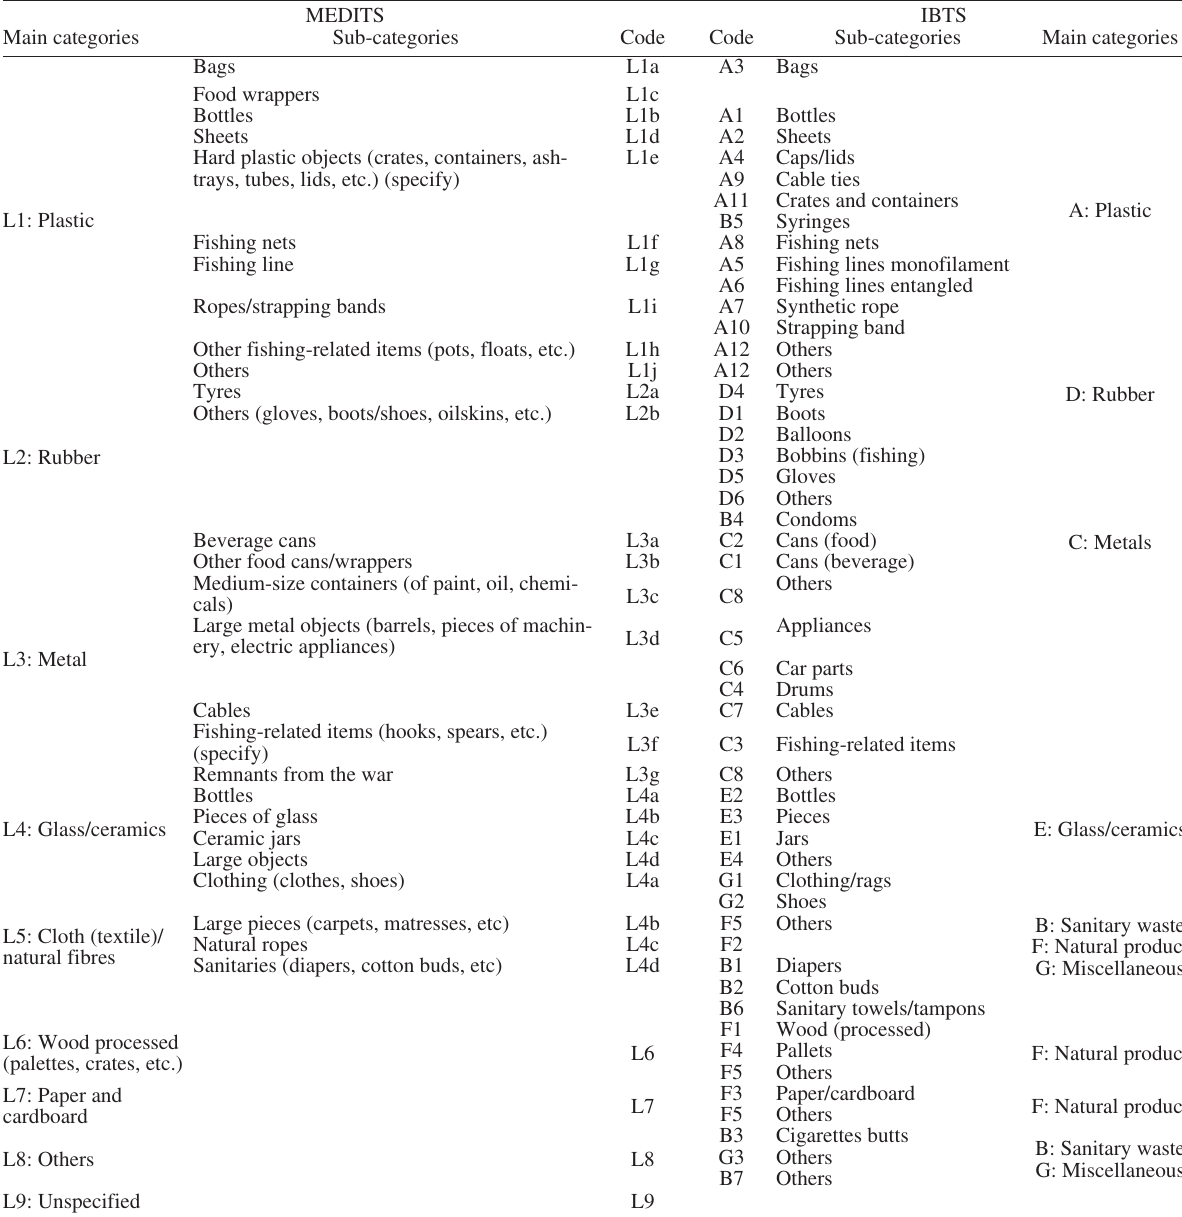
Table 4. – Cross-cutting table of the protocol for the collection of marine macro-litter during the MEDITS bottom trawl surveys and the ICES IBTS surveys. Main litter categories, sub-categories and respective codes are shown.